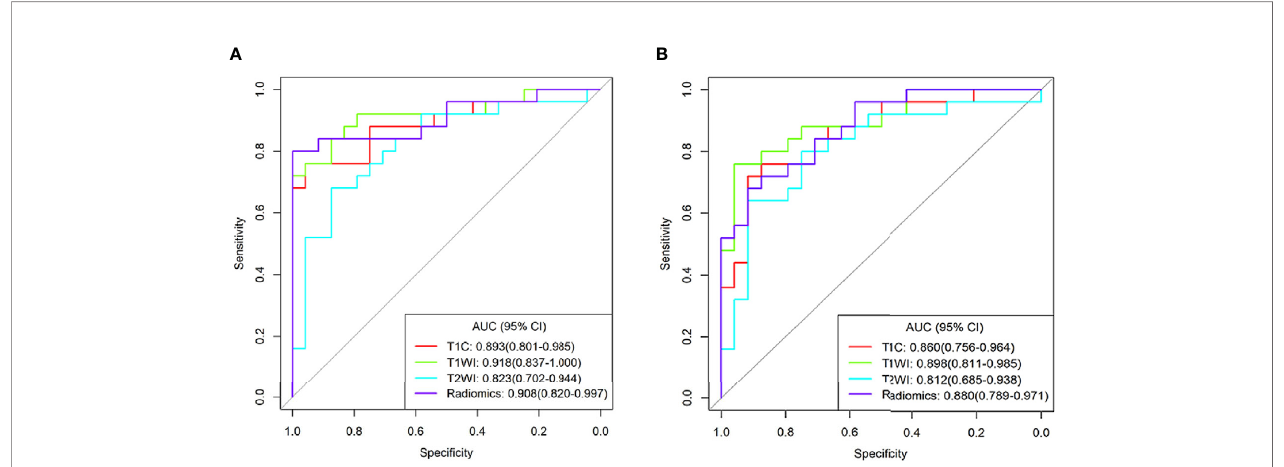
FIGURE 4 | Receiver operating characteristic curves for the differentiating performance of texture signatures from T1C, T1WI, T2WI, and Radiomics between densely granulated and sparsely granulated growth hormone-secreting adenomas. Texture features extracted from region of interest1(ROI 1 ) (A) and ROI 2 (B) , respectively. Radiomics signatures based on the radiomics score, combined the texture parameters from T1C and T1WI. ROI 1 , excluding the cystic/necrotic portion; ROI 2 , containing the whole tumor; AUC, area under curve; CI, con fi dence interval; T1C, contrast-enhanced T1WI.